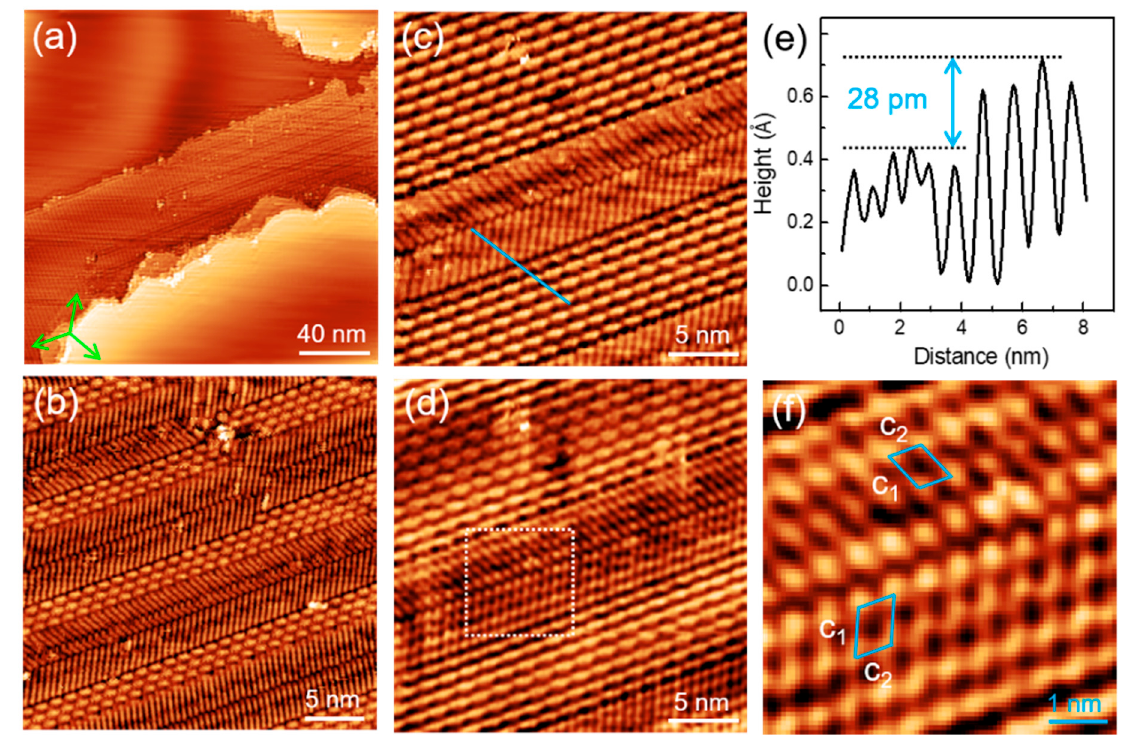
Figure 3. The mixed phase of self-assembled TPB and Cd nanostripes. ( a ) Coexistence of the mixed phase with a domain of 2D self-assembled TPB on the same terrace, − 0.5 V, 70 pA. ( b ) Zoom-in images of the mixed phase, − 0.1 V, 50 pA. ( c , d ) A typical nanostripe of Cd atoms confined by two self-assembled TPB domains. The scanning parameter are 0.1 V, 50 pA ( c ) and 0.01 V, 50 pA ( d ). ( e ) A height profile along the blue line in ( c ), reflecting the height difference between TPB molecules and Cd nanostripes. ( f ) Close-up view of the Cd nanostripes located in the dashed box in ( d ), 0.01 V, 20 pA.